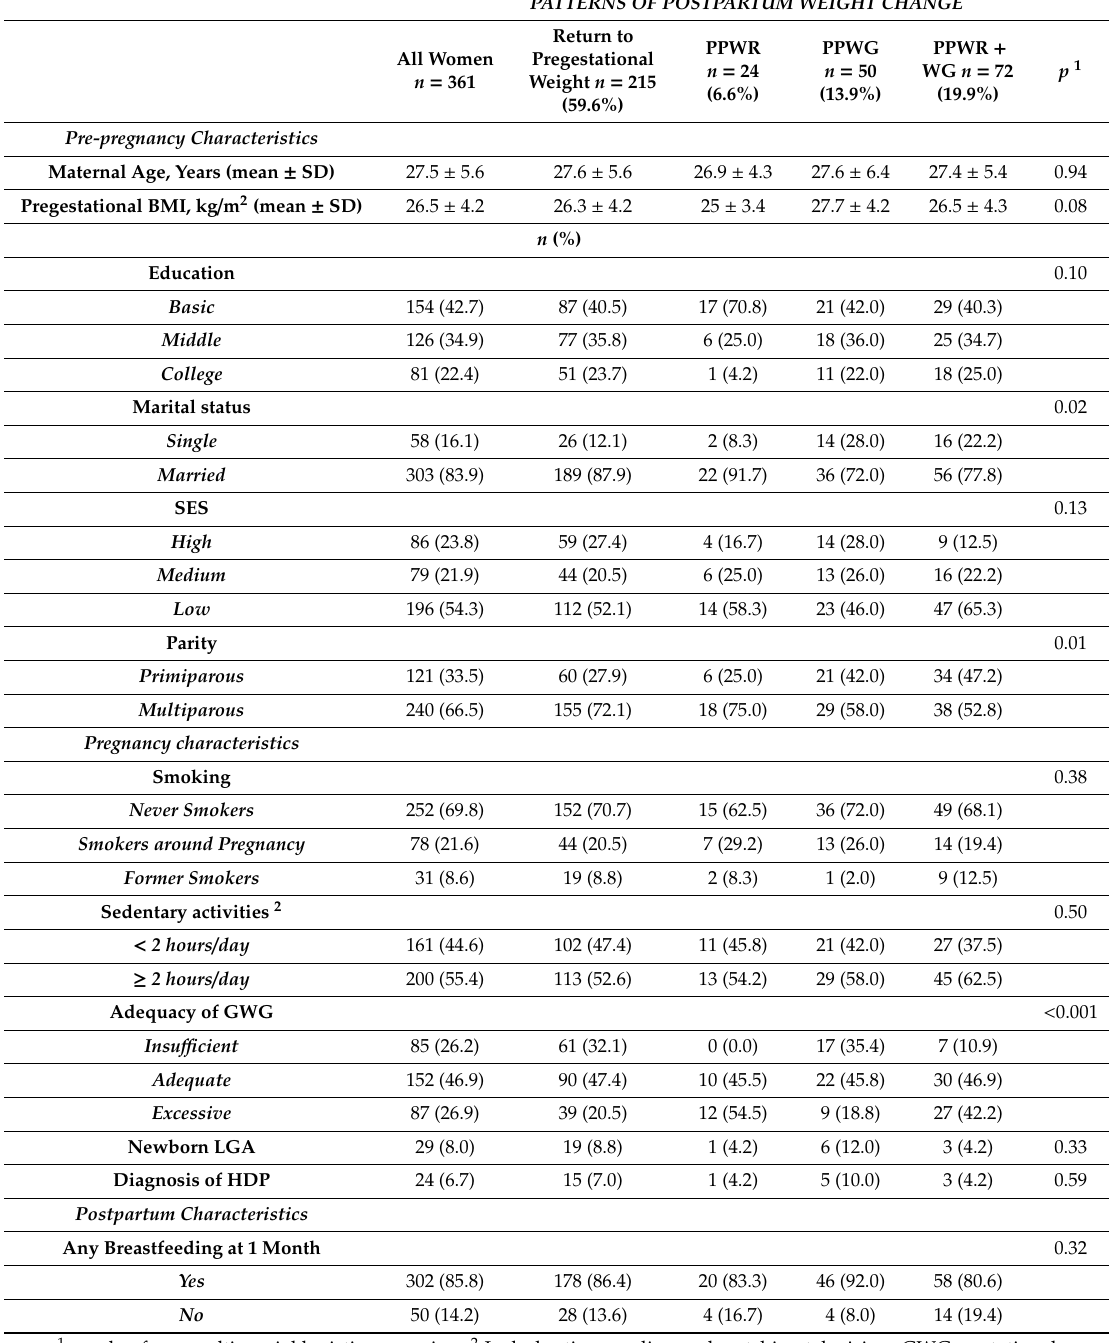
Table 1. Participant characteristics according to patterns of postpartum weight change in women participating in the PROGRESS